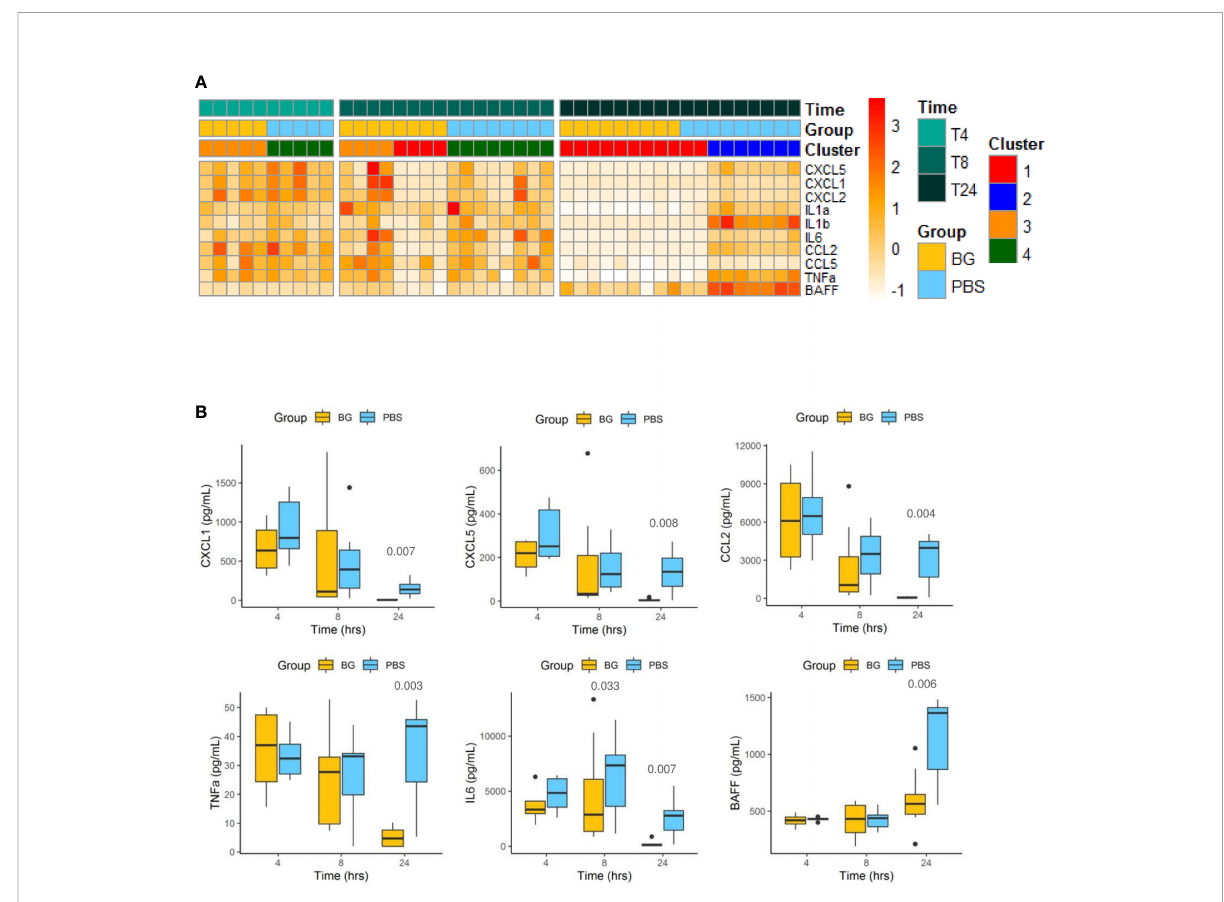
FIGURE 3 Cytokine secretion in peritoneal exudates from individual mice at 4, 8, and 24 h after challenge. (A) Heatmap representation of the cytokine concentrations of each individual (after Z-score transformation) according to experimental group, cluster, and sampling time point. (B) Cytokine concentrations (pg/mL) in exudates determined by multiplexed ELISA. Statistical analysis was performed using the Welch t-test and signi fi cant p values are indicated. The number of mice and experiments are detailed in Supplementary Table